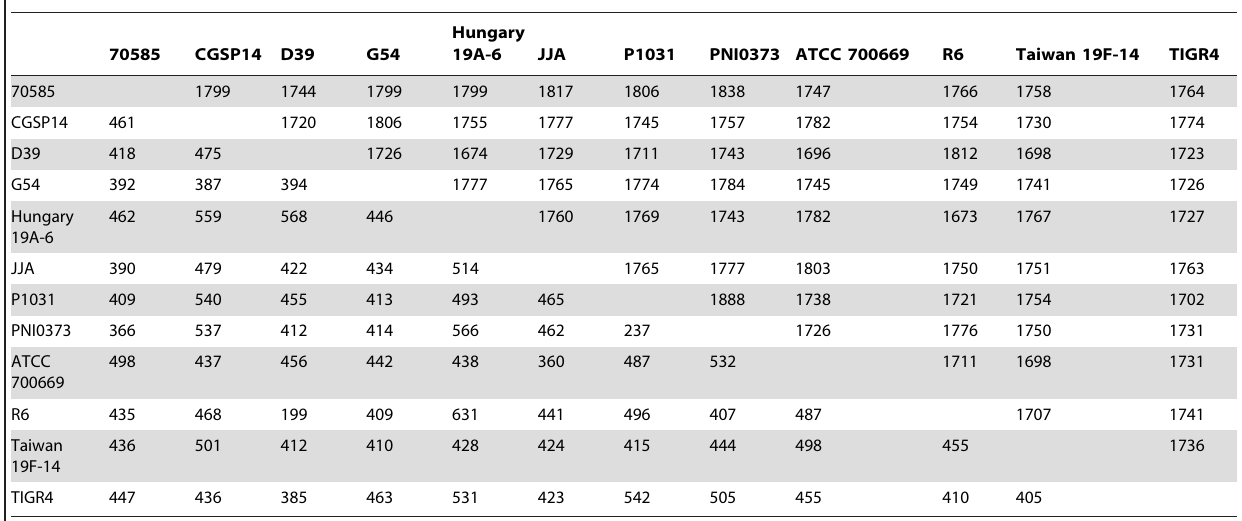
Table 2. Pairwise comparisons of orthologous content.